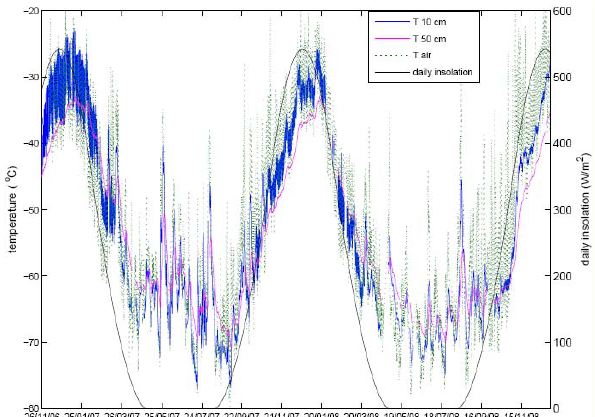
Fig. A1. Evolution of the daily insolation (black), air temperature (dotted green), snow temperature at 10cm depth (blue) and temper- ature at 50cm depth (pink) at the Dome C station between the year 2006 and 2008. The temperature measurements of the snow at Dome C are part of a more complete system which records temperatures every hour at 40 levels from the surface down to 21m since November 2006. Temperatures were measured with 100ohm Platinum Resistance Temperature (PRT) detectors (IEC751 1/10 DIN). A more detailed description of the system and an open data access is available on the OSUG website (http://www.obs.ujf-grenoble.fr). The air tempera- ture sensor is housed in a naturally aspirated, multi-plate radiation shield (Young 41003), and the measurement was performed at 1m height. The lag between the maximum of snow temperatures measured at 10cm and 50cm is due to the diffusion time of the annual wave temperature between these two levels. The obvious decrease of the diurnal amplitude variations of T 10cm during the observed period is due to the snow accumulation at the surface. This accumulation implies also an increase of the lag between air and snow tempera- ture